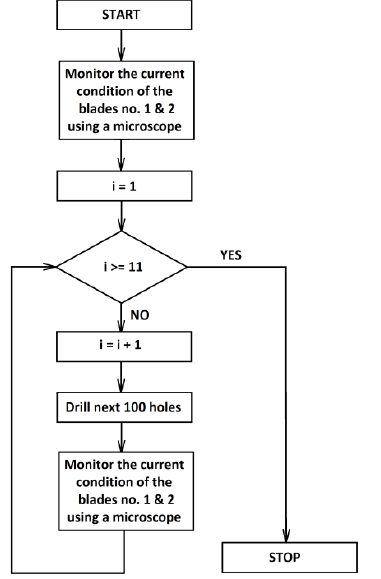
Figure 7. The outer corner wear (W) determination.